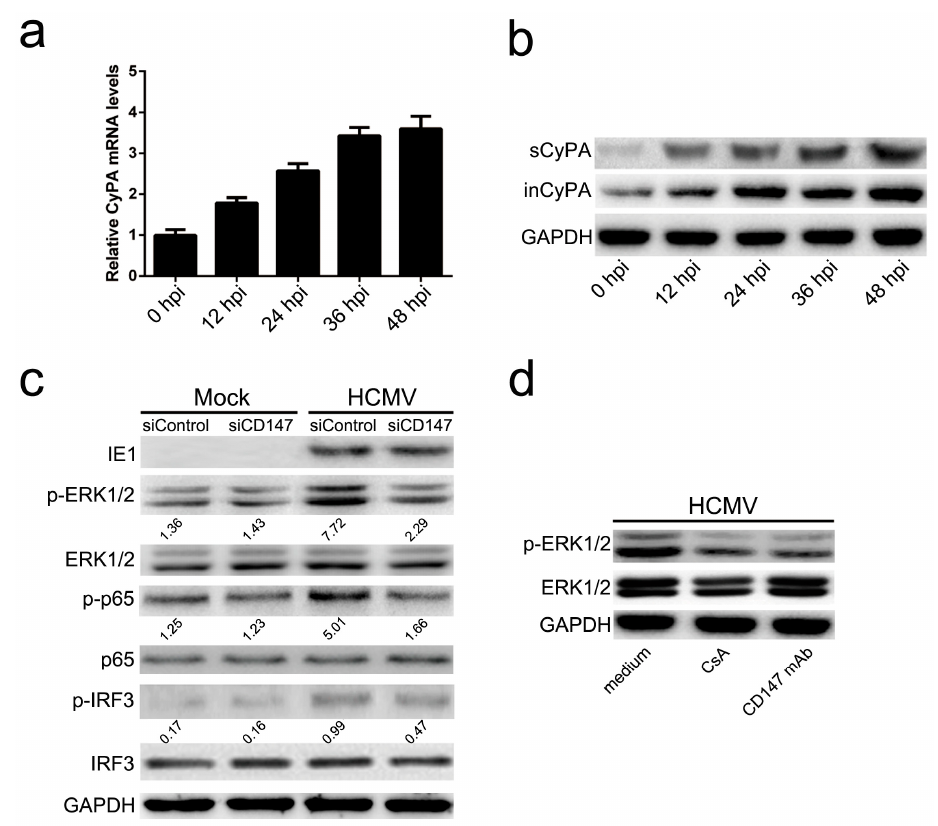
Figure 2. CD147 mediated HCMV-triggered antiviral signaling via the sCyPA-CD147 interaction activated ERK/NF- κ B pathway. ( a ) Quantitative RT-PCR analysis of Cyclophilin A (CyPA) mRNA expression kinetics in HFF cells at different time points post-HCMV infection (MOI = 5); ( b ) Western blot analysis of secreted CypA (sCypA) protein levels and intracellular CypA (inCypA) in total protein lysates in culture mediums of HFF cells at the indicated times post HCMV infection (MOI = 5); ( c ) Western blot analysis of the phosphorylation levels of ERK1/2 (p-ERK1/2), NF- κ B p65 subunit (p-p65) and IRF3 (p-IRF3) in response to HCMV infection for 6 h (MOI = 0.5) compared to mock infection (Mock) with the medium only. The intensities of bands were quantified by Image Lab 4.0 (Bio-Rad) and relative values normalized to GAPDH are indicated by the numbers under the lanes; ( d ) Analysis of the phosphorylation activation of ERK1/2, induced by HCMV infection for 6 h (MOI = 0.5) with the culture medium, pre-supplemented with cyclosporine (CsA) (5 µ g/mL) or CD147 mAb (50 µ g/mL).